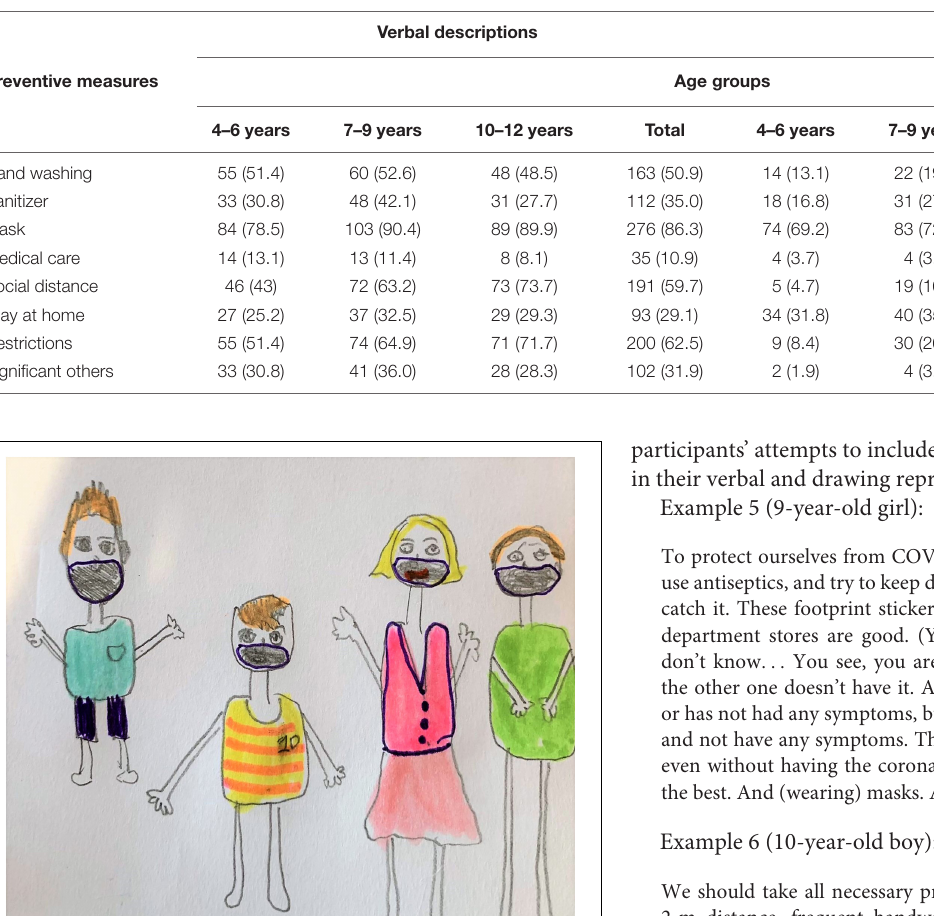
TABLE 2 | Frequencies (and %) of preventive measures in children’s verbal descriptions and drawings by age group.